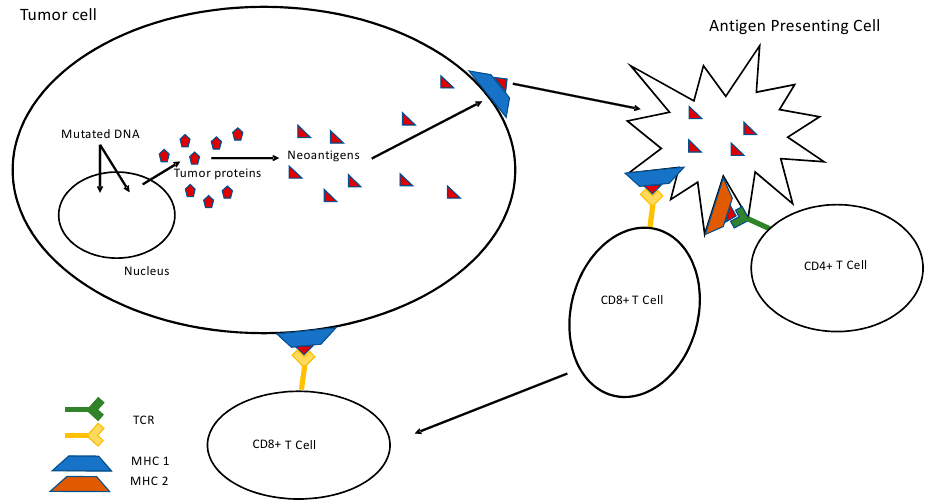
Figure 1. Link between Tumor Mutational Burden and T specific antitumoral response. Abbreviations: DNA, Deoxyribonucleic Acid; MHC, Major Histocompatibility Complex; TCR, T-cell